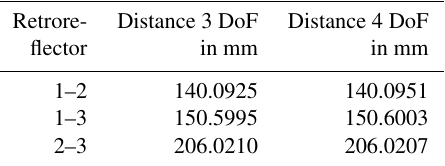
Table 1. Resulting retroreflector distances from self-calibration with 3-DoF and 4-DoF